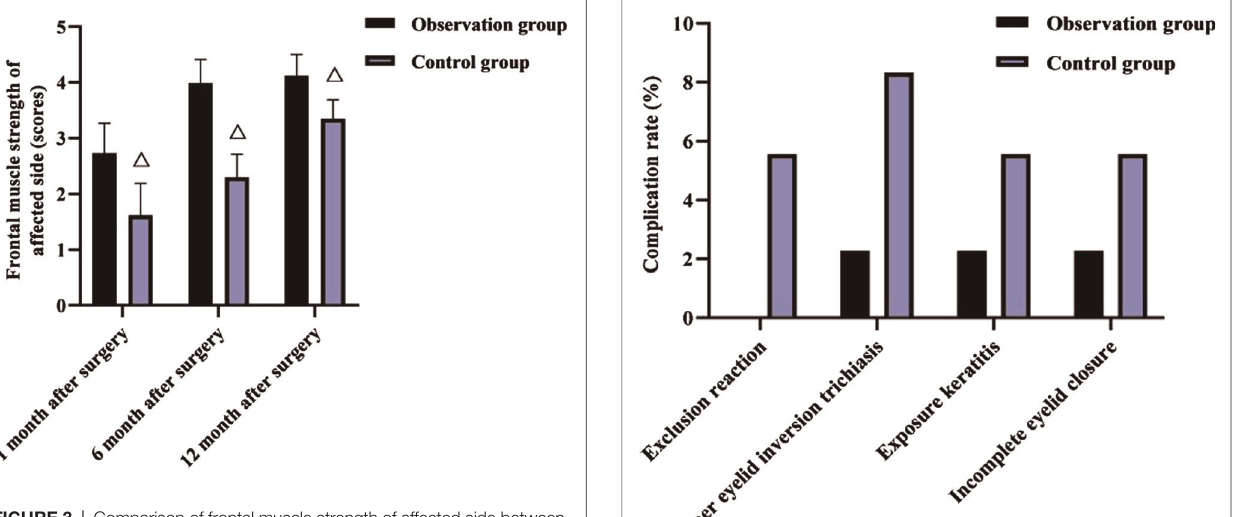
FIGURE 3 | Comparison of frontal muscle strength of affected side between two groups in each month after surgery ( (cid:1) x + s , score). Note: Compared with the observation group at the same time, △ p <0.05.